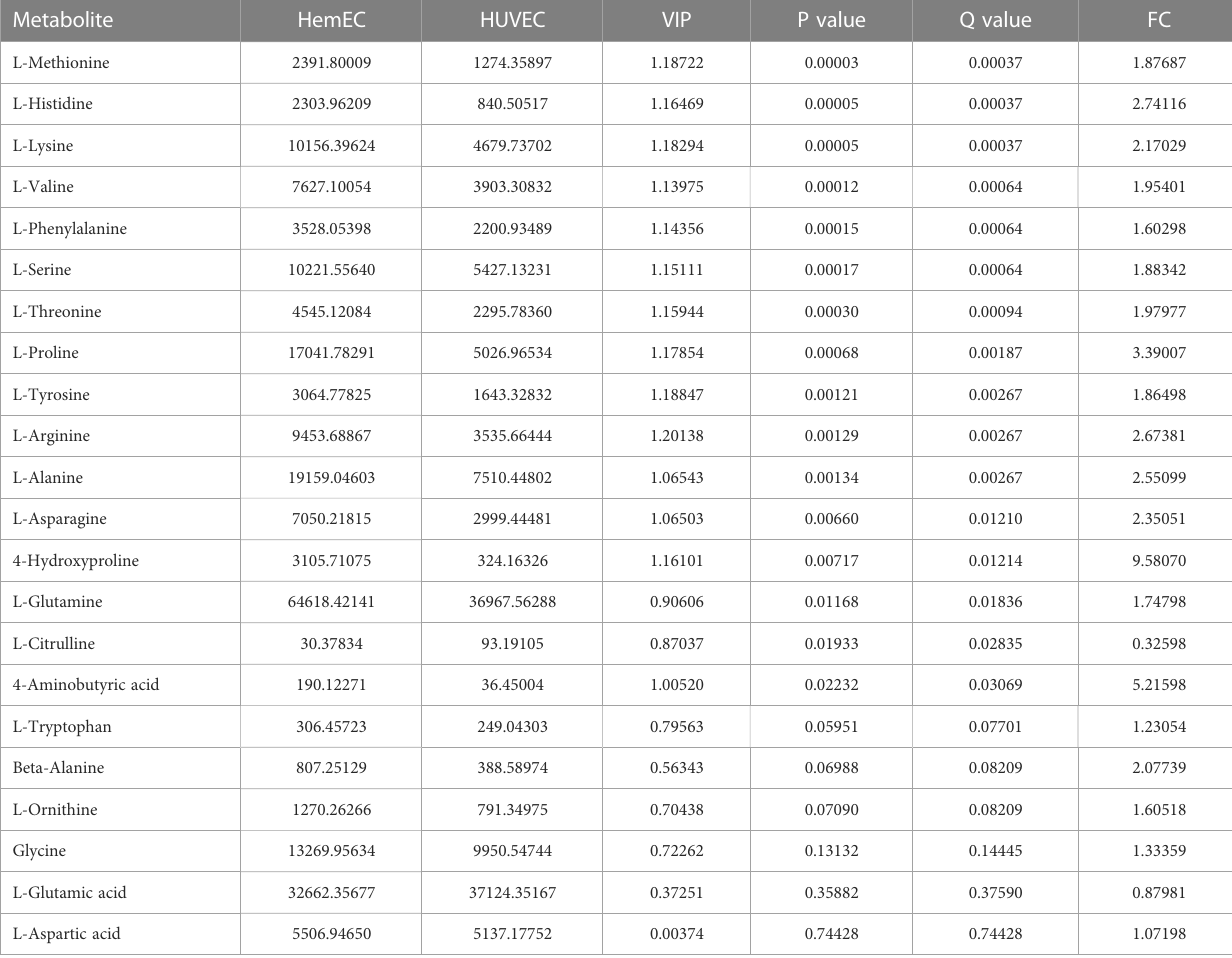
TABLE 3 Twenty two differential amino acid between HUVEC and HemEC by targeted metabolic analysis. Metabolite HemEC HUVEC